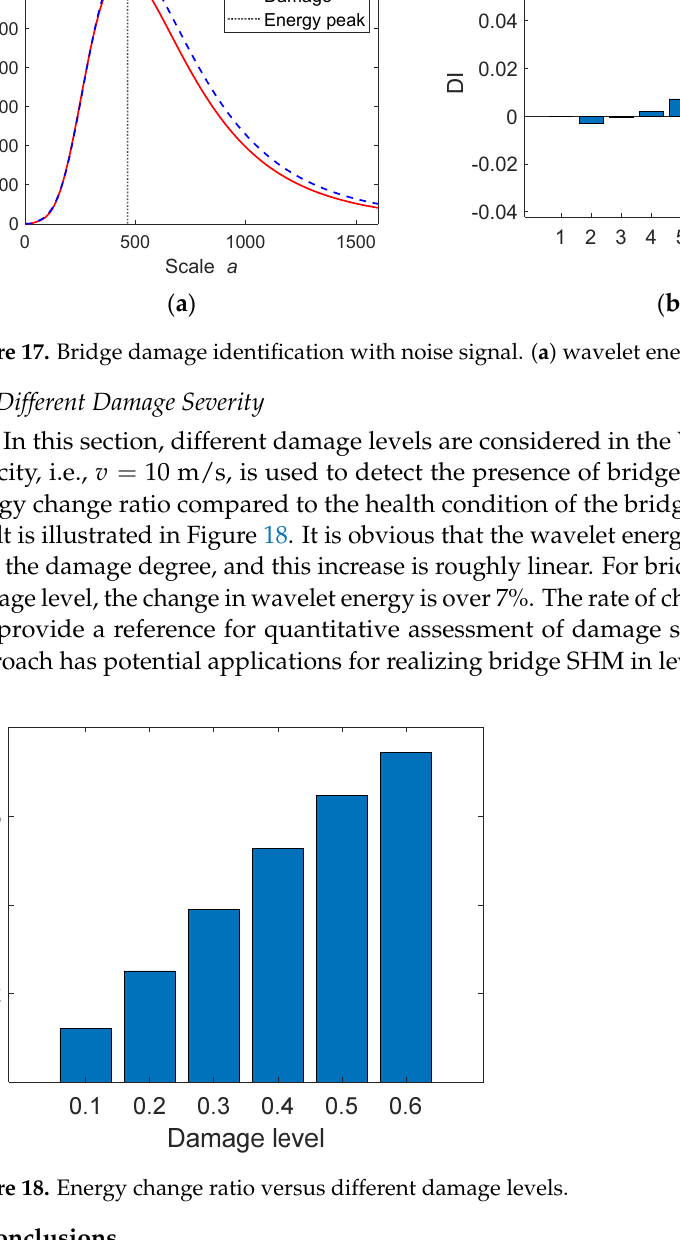
Figure 16. Vehicle acceleration with noise. ( a ) 𝑣 = 10 m/s; ( b ) 𝑣 = 2.5 m/s.